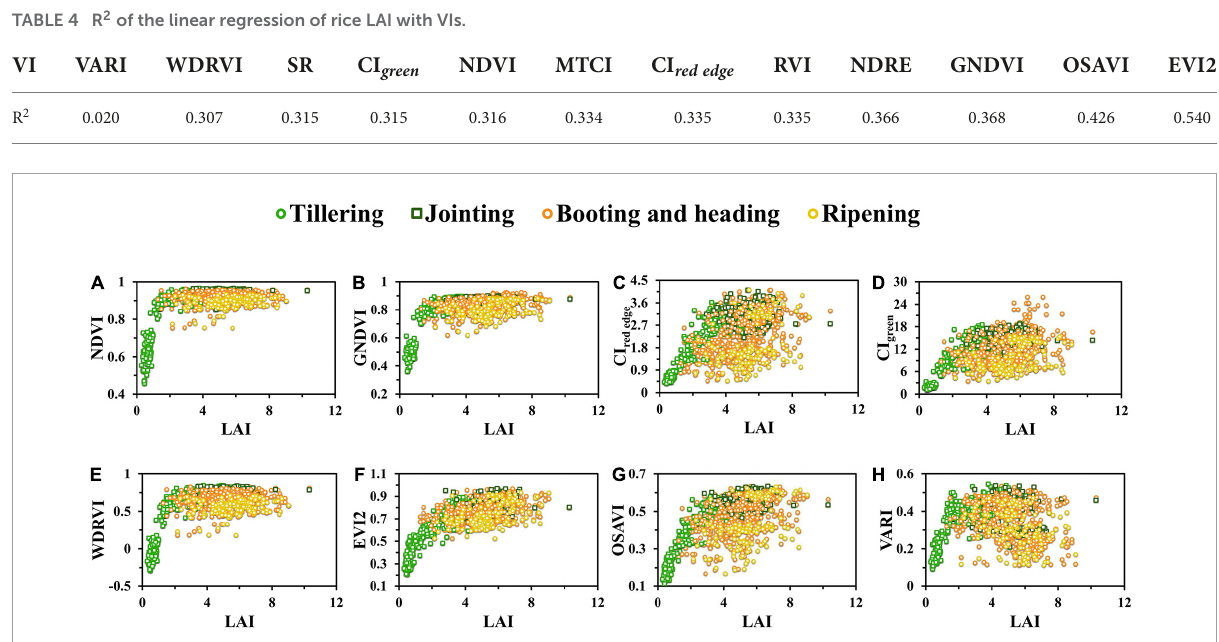
FIGURE4 Variation of LAI plotted against vegetation indices: (A) NDVI, (B) GNDVI, (C) CI rededge , (D) CI green , (E) WDRVI, (F) EVI2, (G) OSAVI, and (H) VARI. The scattered points were marked with four colors according to the growth stages of rice: tillering, jointing, booting and heading, and ripening.